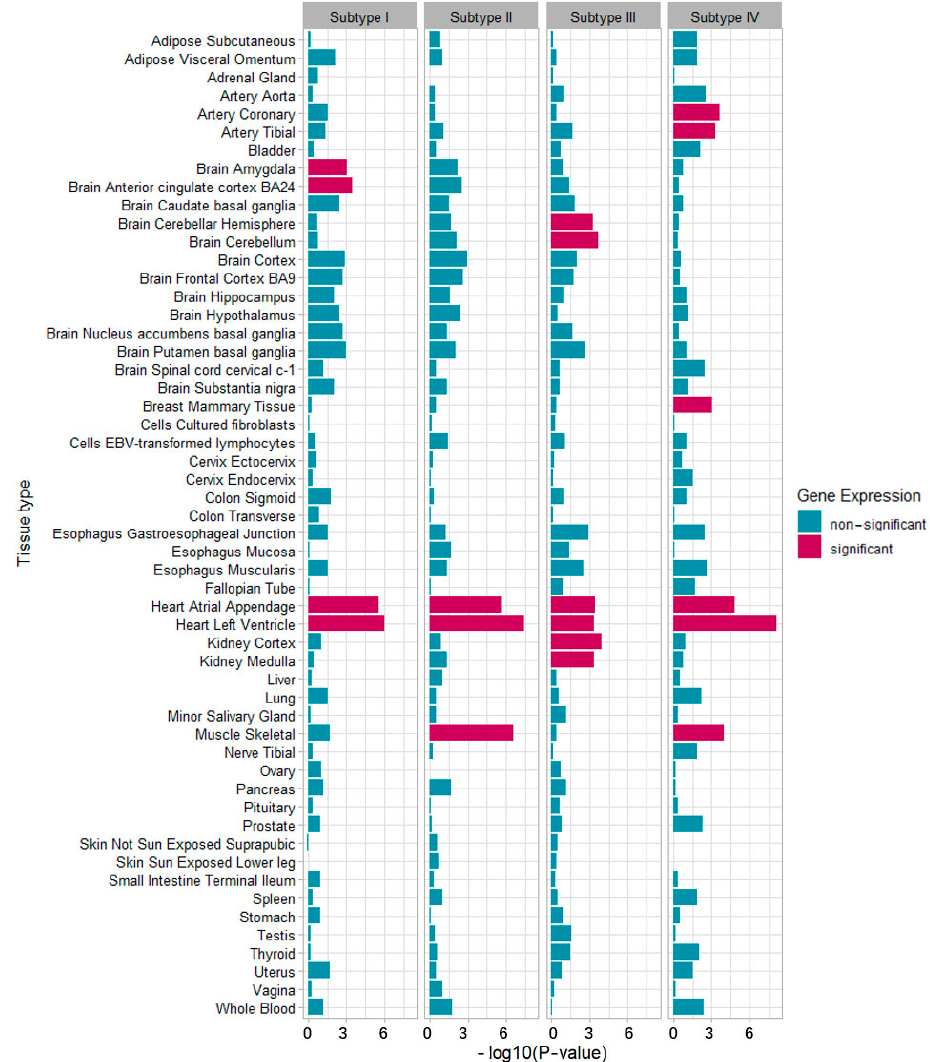
Figure 5. GTEx tissue-specific enrichment analysis for metabolic subtypes *. * Subtype I, adiposity- dominant type; Subtype II, hypertension-dominant type; Subtype III, hyperglycemia-dominant type; Subtype IV, dyslipidemia-dominant type.